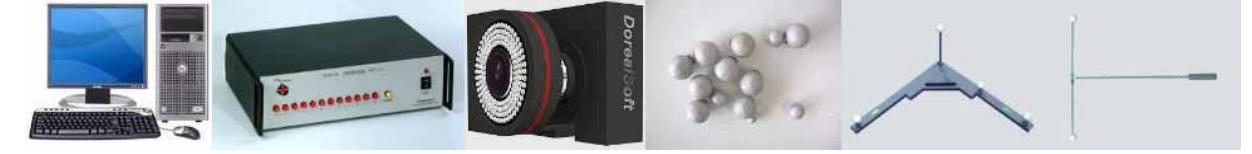
Fig. 3 Optical capture device hardware